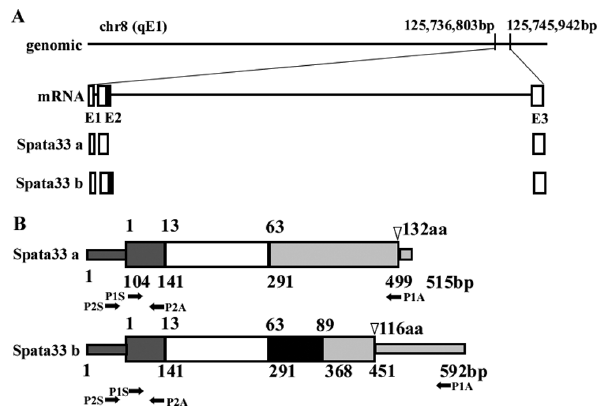
Figure 1. Identification of two transcript variants of the gene Spata33 . A). Schematic representation of the genomic structure and alternative exons of the gene Spata33 . Mouse Spata33 was spliced by alternative 5 9 splice site. White blocks represent 3 exons and black block shows alternative exon. B). Schematic view of alternatively spliced transcripts of the Spata33 gene. Transcript a (GenBank: NM_177279.4) encodes a 132-aa protein. An insertion of expanded exon 2 results in a frameshift, which causes early termination of transcript b (GenBank: CA466259.1). Numbers above the wide rectangles show the amino acid sites, and the numbers below represent nucleotide sites. The locations of the stop codons for each variant are showed in white triangles. Arrows with P1S and P1A indicate RT-PCR primers, and arrows with P2S and P2A denote quantitative RT-PCR primers.